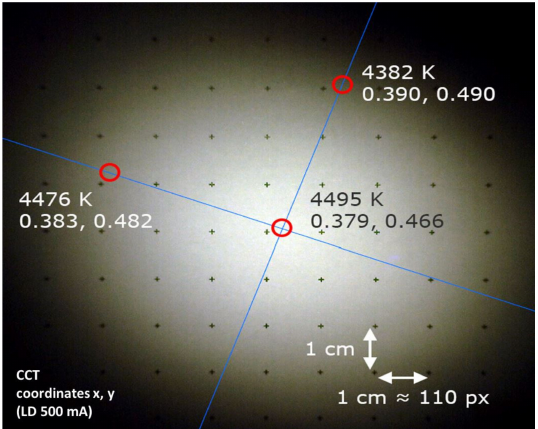
Figure 19. Target spot of the reflective LARP setup nr. 2 at a distance of 330 mm from the light